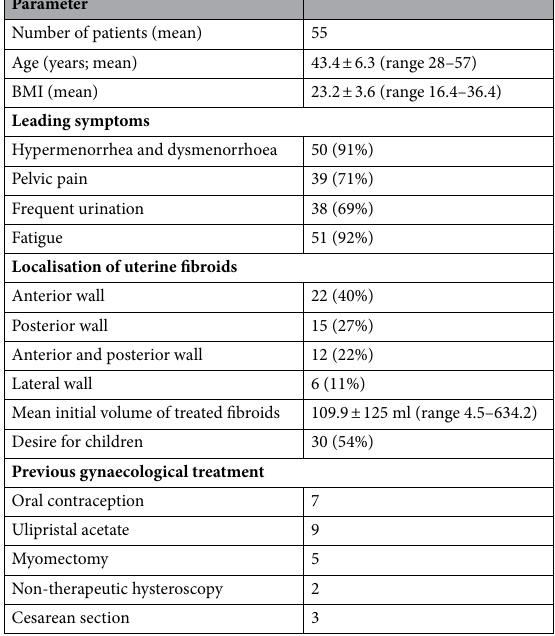
Table 1. Clinical characteristics of HIFU-treated patients with uterine fibroids.